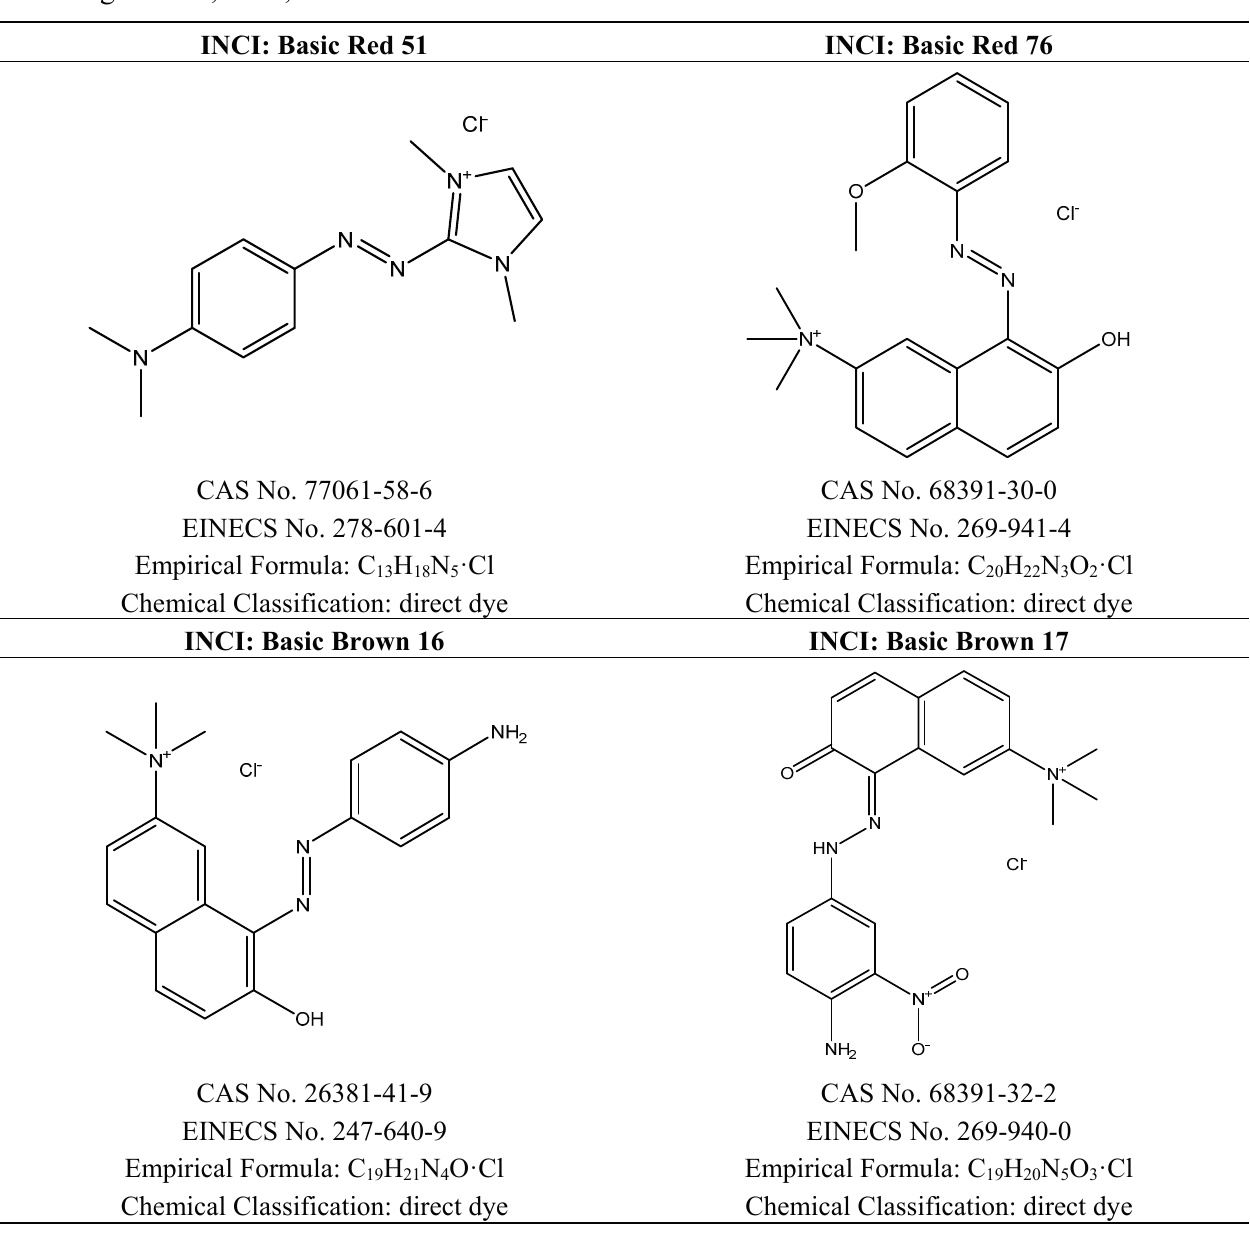
Table 3. Structural and molecular formulas of cationic dyes used in semi-permanent hair dyeing formulation [23]. Legend: INCI, International Nomenclature of Cosmetic Ingredients; CAS, Chemical Abstract